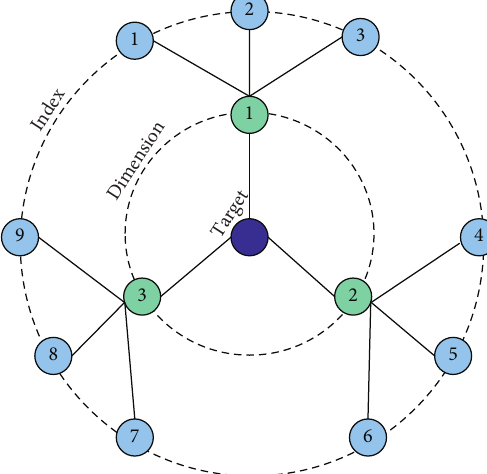
Figure 5: Three-level standardized framework for the index